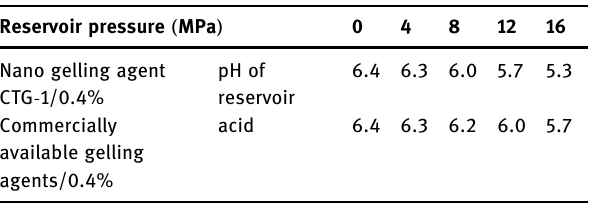
Table 3: E ff ect of reservoir pressure on acid fl uid loss coe ffi cient